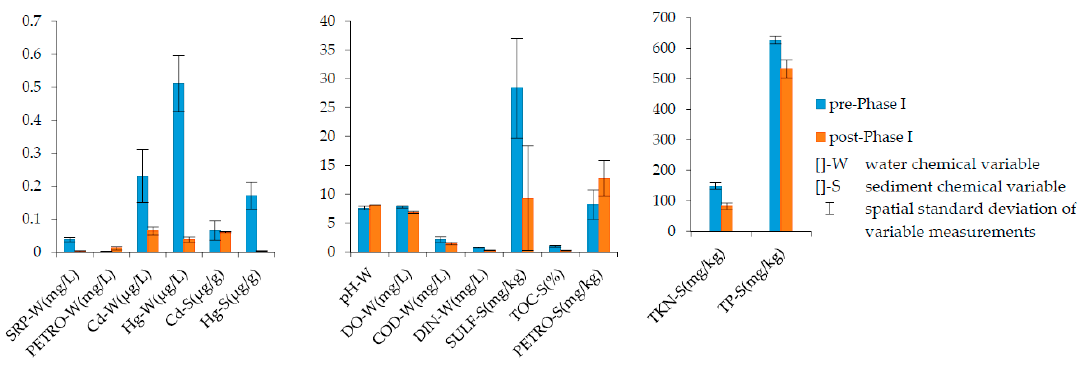
Figure 5. Comparison of environmental variable measurements between pre- and post-Phase I project. Water 2018 , 10 , 69